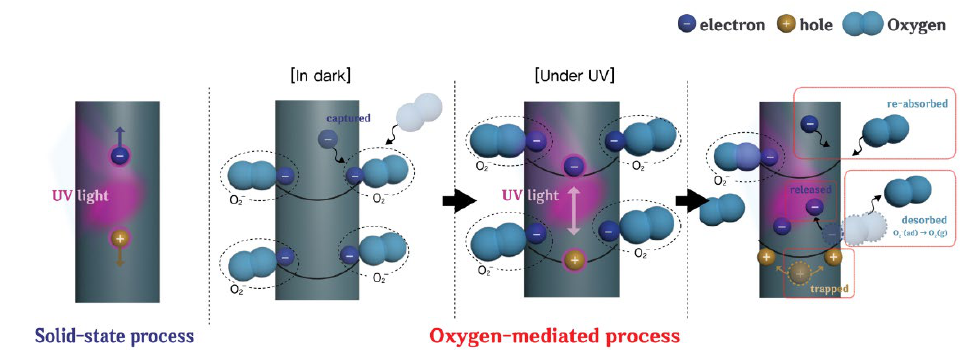
Figure 6. The solid-state process and oxygen-mediated mechanism of the ZnO-based PD.